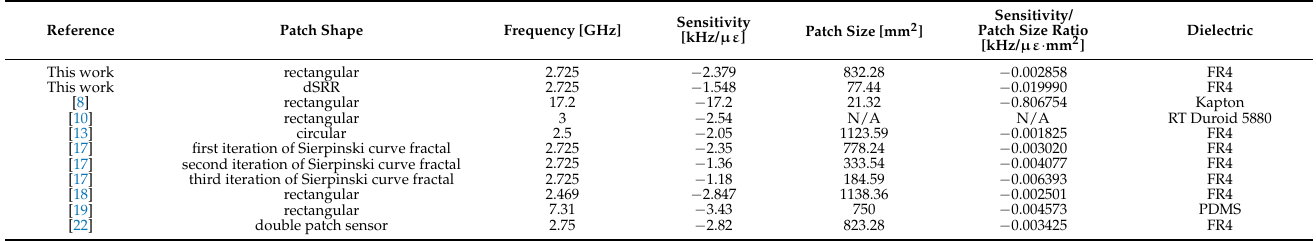
Table 2. Comparison of recently reported microstrip strain